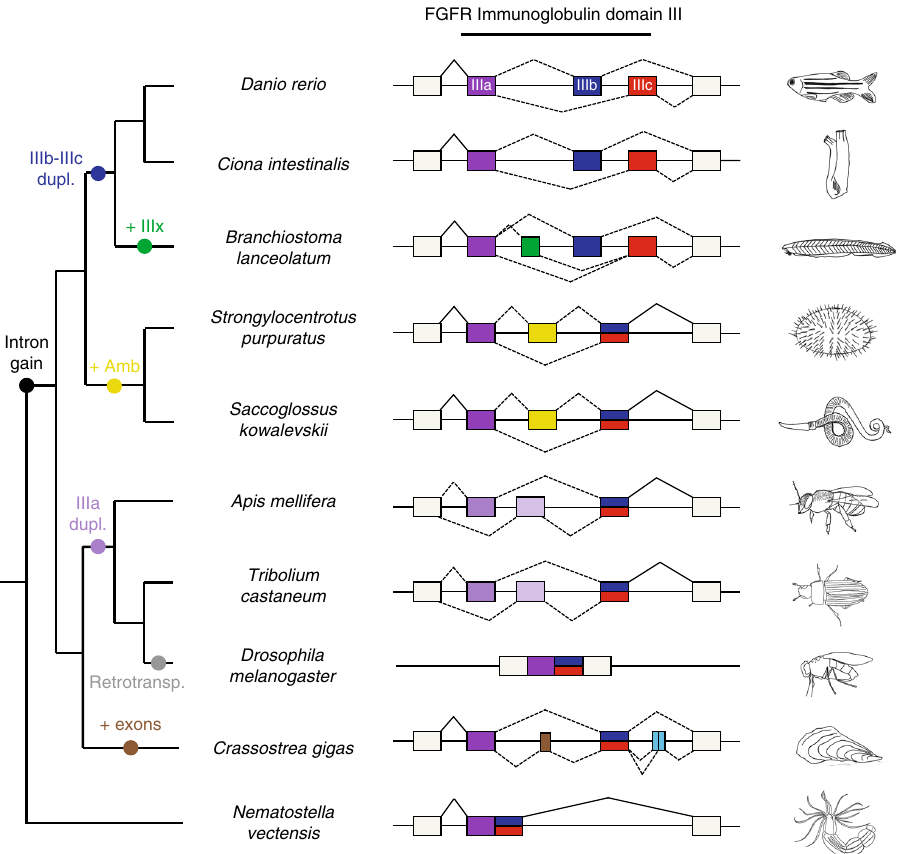
Fig. 7 Gene structure and AS at the IgIII domain of the Fgfr gene family in metazoans. Schematic representation of the AS diversity in the region encoding the homolog of the Fgfr IgIII domain for zebra fi sh ( Danio rerio ), vase tunicate ( Ciona intestinalis ), amphioxus ( Branchiostoma lanceolatum ), purple sea urchin ( Strongylocentrotus purpuratus ), acorn worm ( Saccoglossus kowalevskii ), honey bee ( Apis mellifera ), red fl our beetle ( Tribolium castaneum ), fruit fl y ( Drosophila melanogaster ), paci fi c oyster ( Crassostrea gigas ), and starlet sea anemone ( Nematostella vectensis ). Boxes represent exons, horizontal lines are introns, and diagonal lines connect splicing junctions. Homologous to vertebrate exons IIIa, IIIb, and IIIc are shown in purple, blue and red, respectively. The non- chordate pro-orthologous exon of exons IIIb and IIIc is colored half blue and half red. The amphioxus- and ambulacrarian-speci fi c alternative exons are depicted in green and yellow, respectively. Light violet colors are used for the insect-speci fi c mutually exclusive event involving exon IIIa, and brown and light blue for oyster-speci fi c exons. Gray exons are constitutive in all species. Fruit fl y orthologs ( heartless and branchless ) are intronless genes. Dupl: duplication; Amb: ambulacraria-speci fi c exon; retrotransp.: